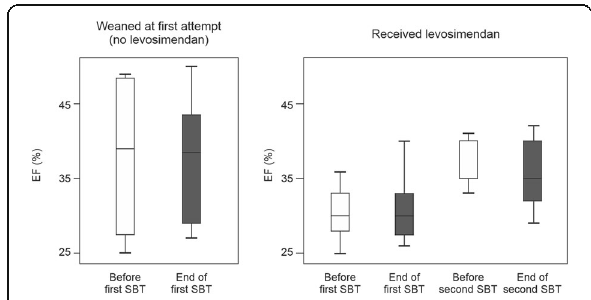
Fig. 2 Effect of levosimendan in weaning from mechanical ventilation in patients with left ventricular dysfunction. Left ventricular ejection fraction (LVEF) before the start (white boxes) and at the end (grey boxes) of spontaneous weaning trials in successfully weaned patients ( left ) and in those who failed and received levosimendan ( right ). LVEF increased after levosimendan administration. Figure drawn freely from the data reported by Kaltsi et al. [40]. SBT, spontaneous breathing